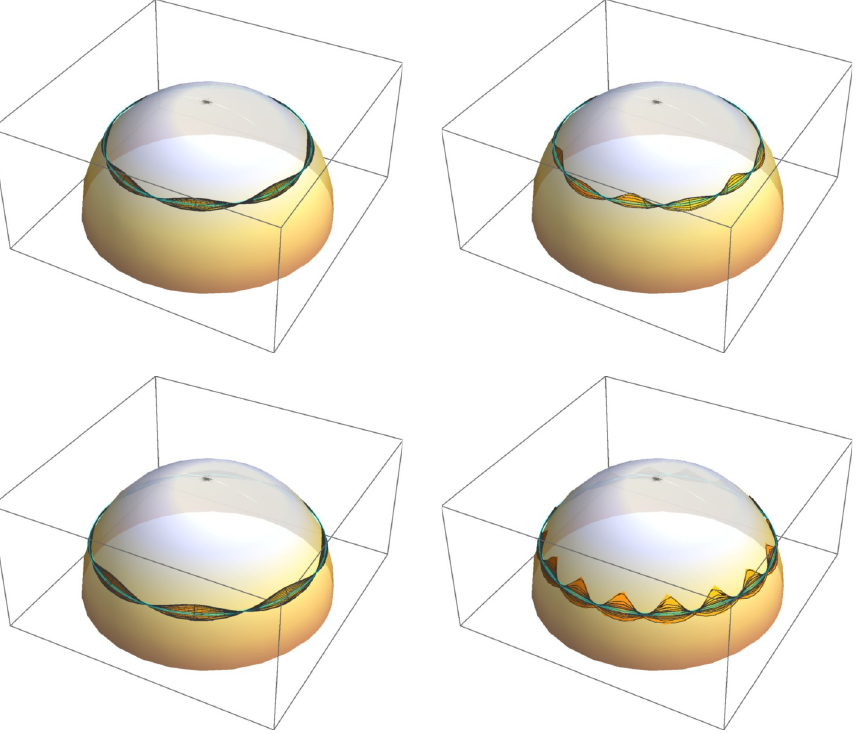
Figure 1 . The trajectory of oscillating giant gravitons with KK modes. The green lines denote the BPS ground states. We set ( j, k ) = (0 . 4 , 2) for top left, ( j, k ) = (0 , 4 , 4) for top right, ( j, k ) = (0 . 2 , 2) for bottom left, ( j, k ) = (0 , 2 , 6) for bottom right. Other parameters are R = 1 , (cid:15) = 0 . 15 , c